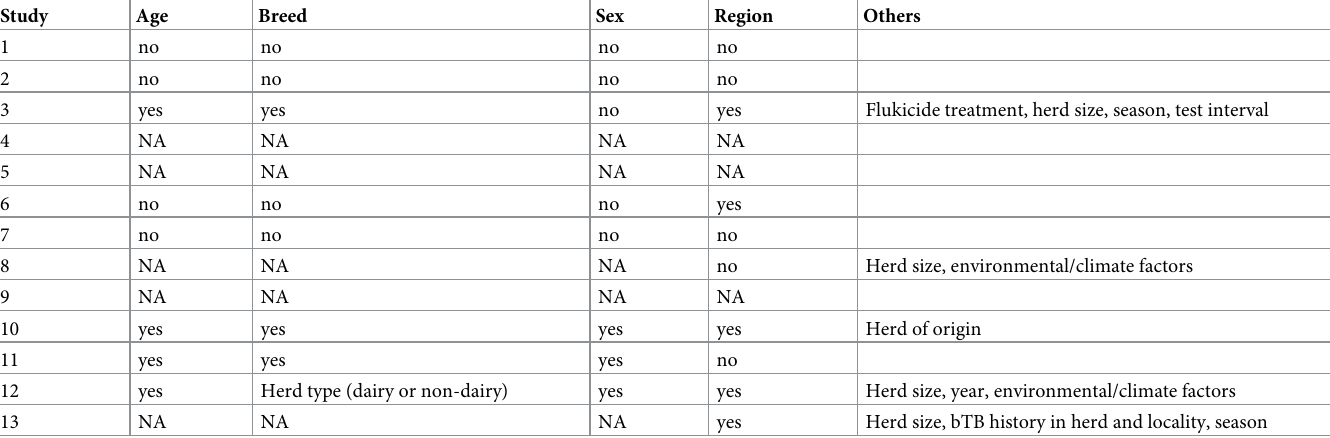
Table 3. The confounders controlled for in each study included in the systematic review on liver fluke and bovine TB. Study